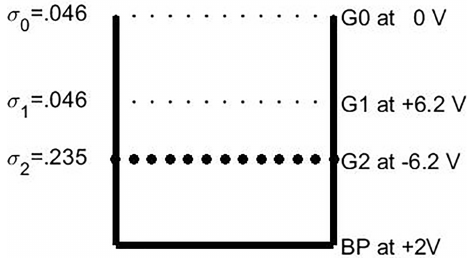
Figure 1. The design of the DUSTY probe used in the MAXIDUSTY campaign. The fractional coverage of the different grids, relative to the total probe cross section, are σ 0 = σ 1 = 0 . 046 and σ 2 = 0 . 235. The electric potentials of all the grids and the bot- tom plate are relative to the payload potential (cid:56) P . The currents are measured on G1, G2, and BP but not on